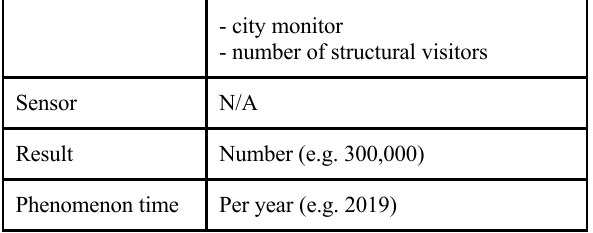
Table 2. Description of the profile